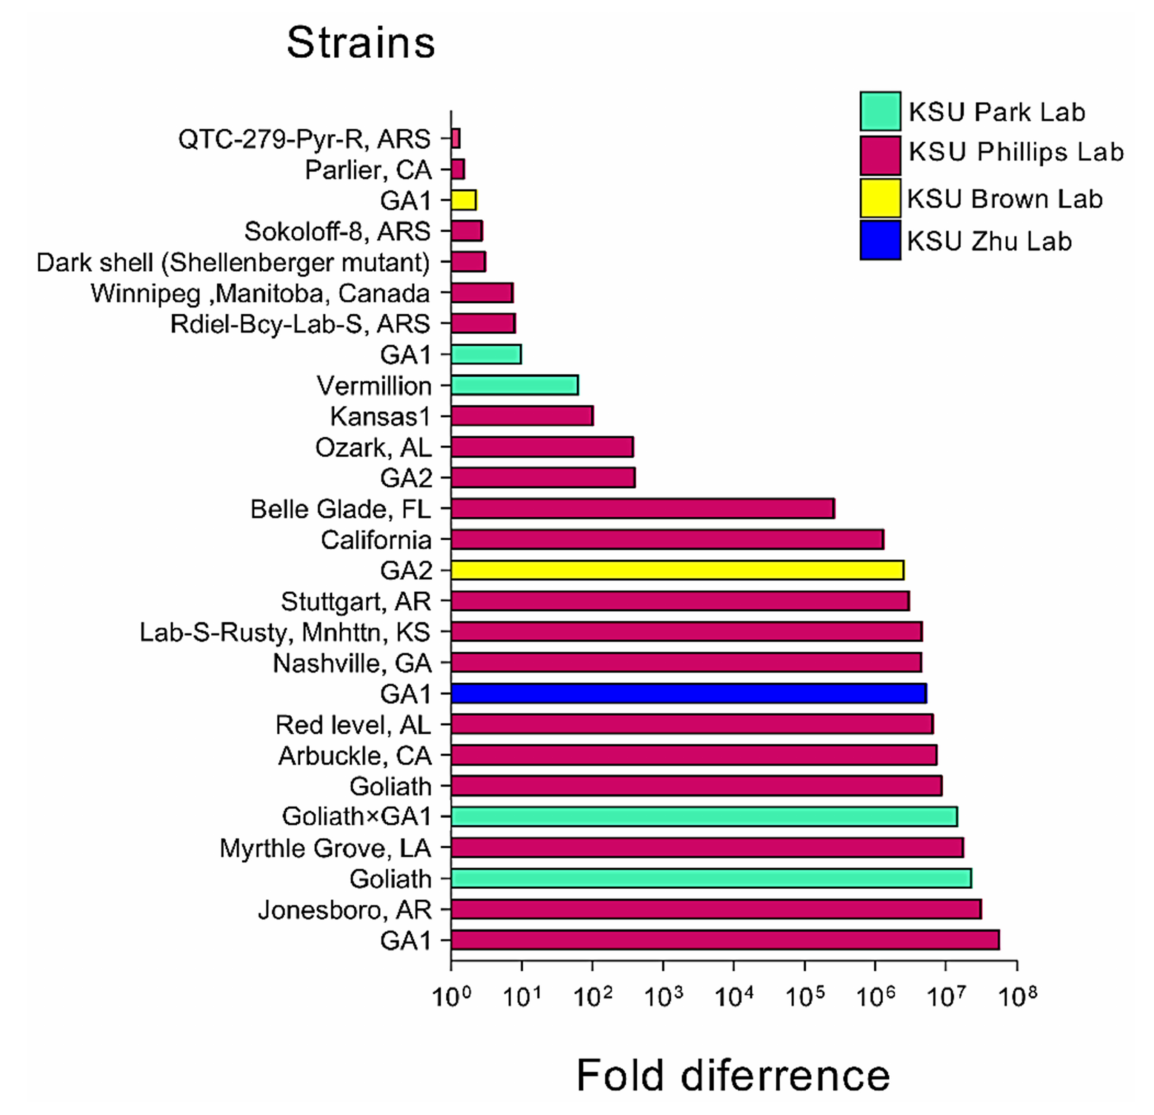
Figure 2. TcIV prevalence measured by RdRp qPCR in different T. castaneum strains. QTC-279-Pyr-R strain having the Ct cycle 37 was used as reference 1. Please note that the colors indicate different laboratories that had the same strains with different levels of TcIV . Details for the strains are in Supplementary Data